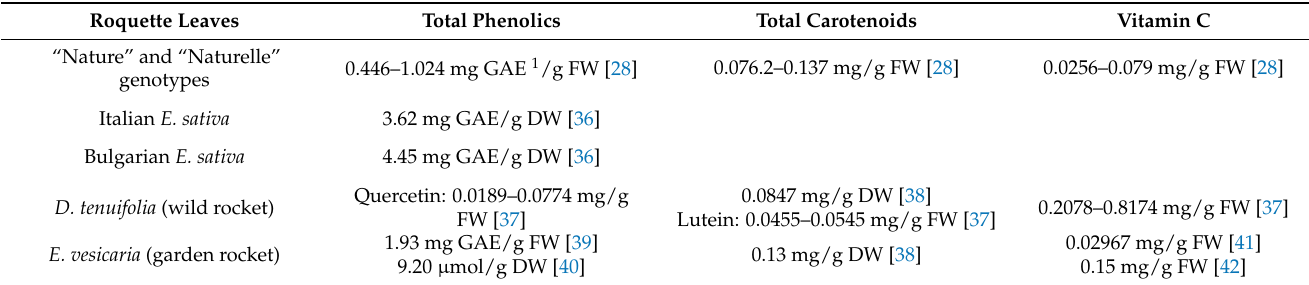
Figure 2. Scheme of the main features of roquette. (Source photo: biodiversitàpuglia.it [35]). Table 2. Some examples of phytochemical compounds in roquette.